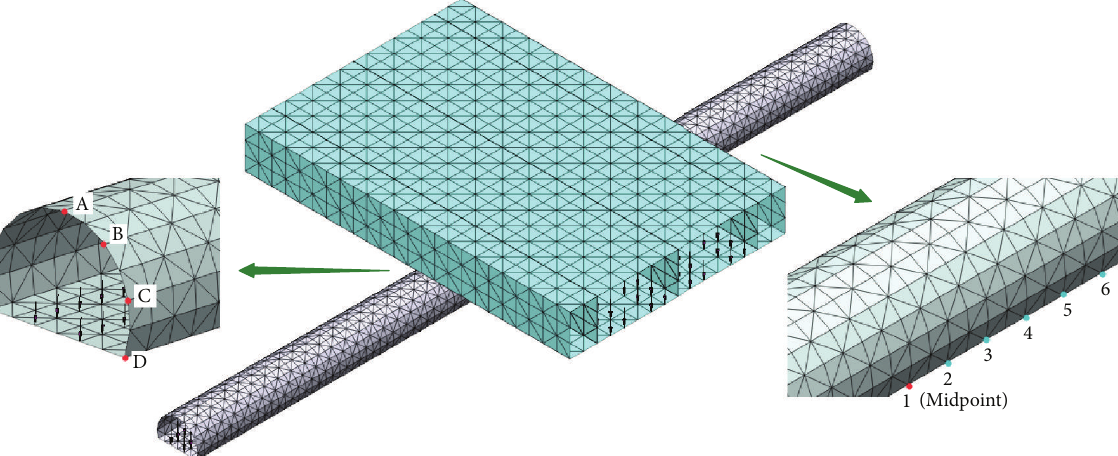
Figure 7: Location of selected points.